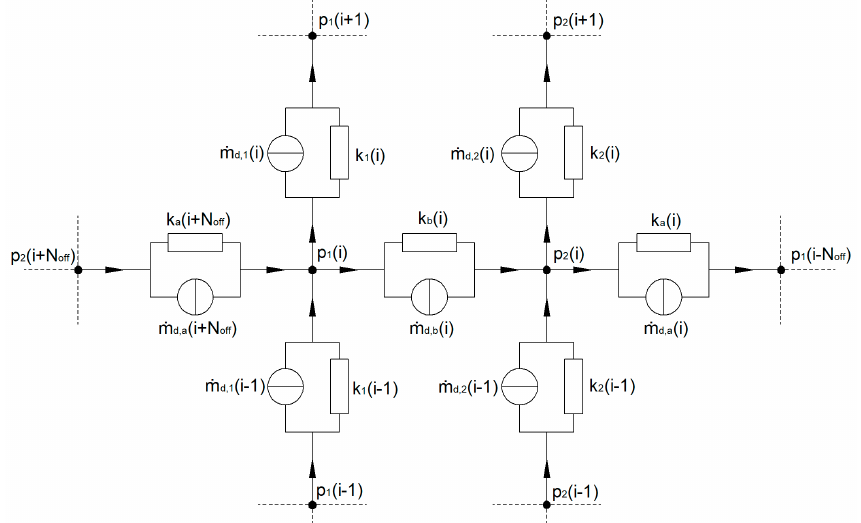
Figure 10. Equivalent circuit diagram.